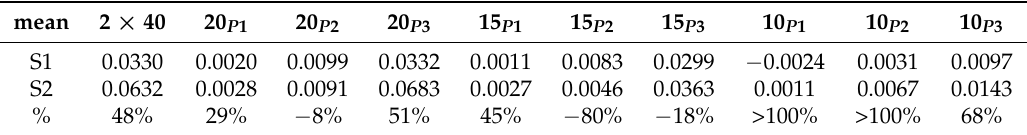
Table 4. The mean value indicators (mean) calculated for the 1st electrode measurement cycle (with 2..32). Where 10, 15, 20, 40 stands for object diameter and P1, P2, P3 determine object